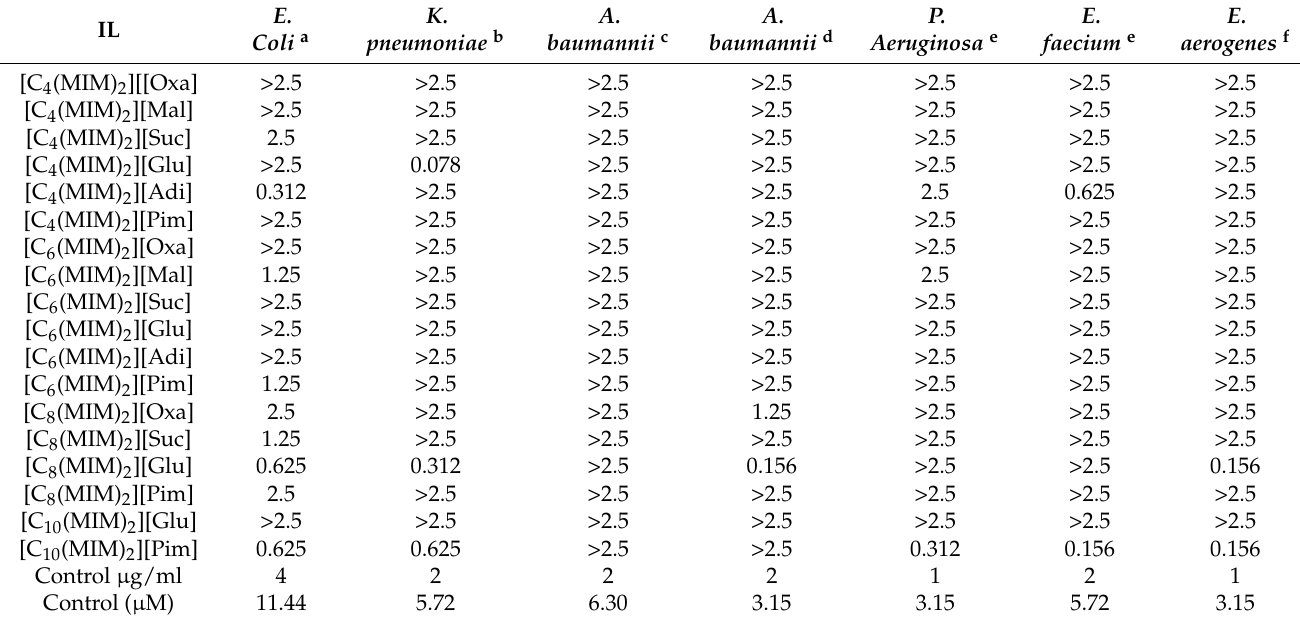
Table 5. MICs (in mM) of DILs against Gram-negative